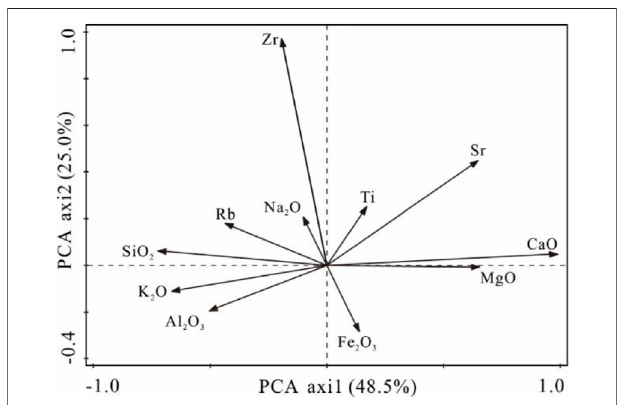
FIGURE 3 | PCA biplot of different elements in the surface sediments of the Bashang